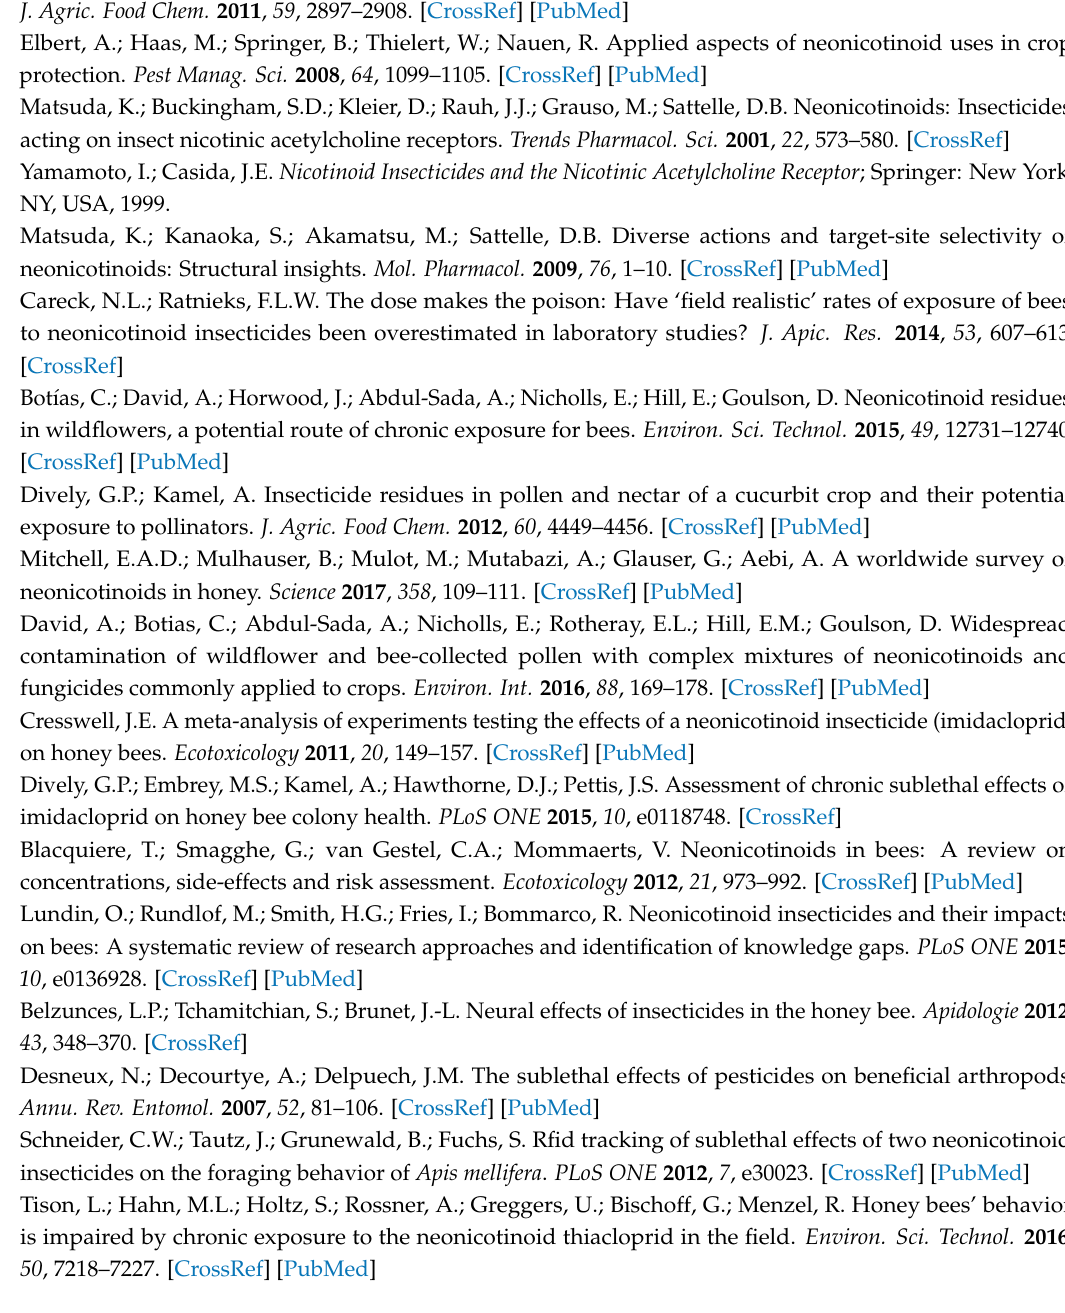
Figure S1: Honey bee mortality, Table S1: Components and composition of pollen patties provided to caged honey bees, Table S2: Results from pesticide analyses (GS-MS/MS) of clothianidin and imidacloprid residues in pollen patties and sugar syrup provided to honey bees in experimental